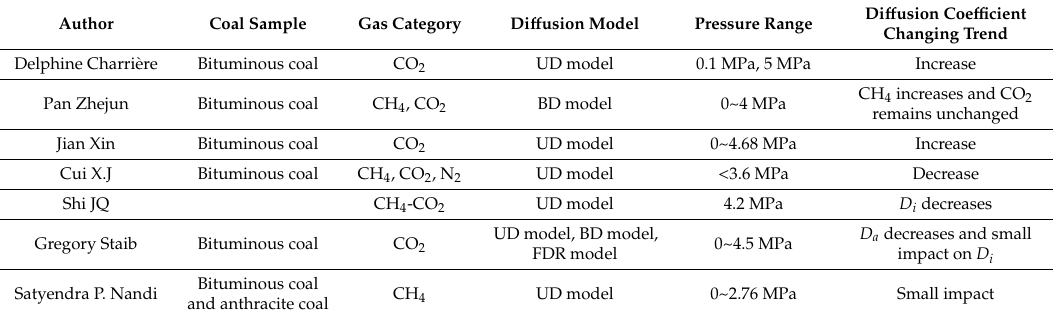
Table 1. Summary of di ff usion coe ffi cient changing trend with the increase in